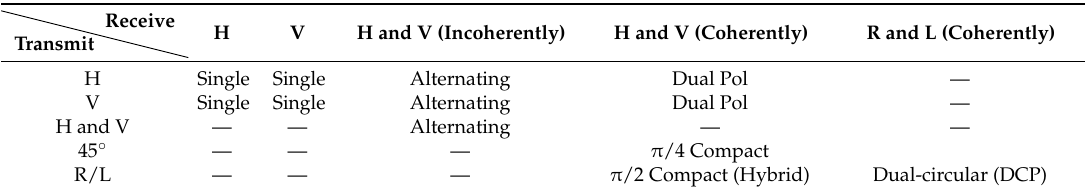
Table 2. Different polarimetric SAR